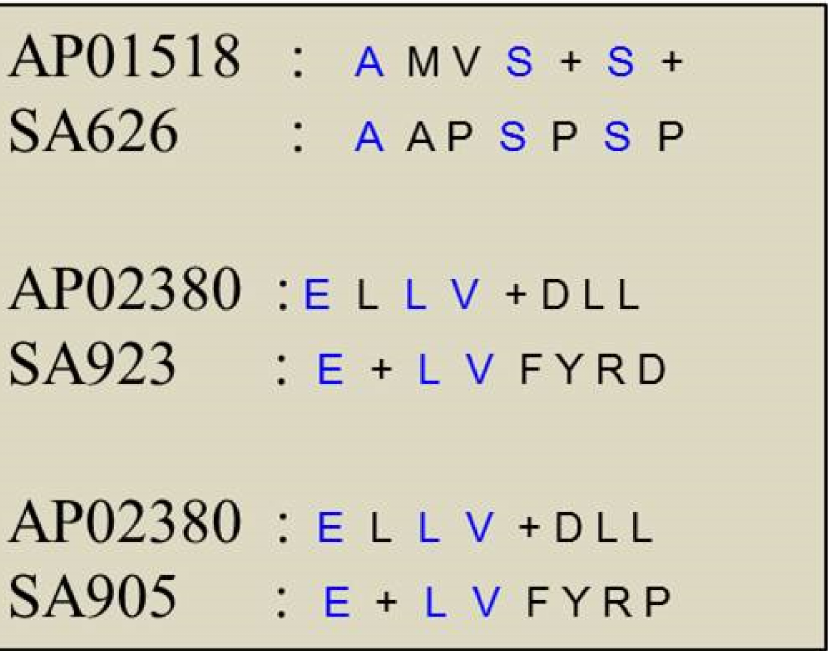
Figure 3. Sequence alignment of peptides SA626, SA923, and SA905 with AMPs (AP01518 and AP02380) from APD3 database showed 42.85% and 37.5% similarities,